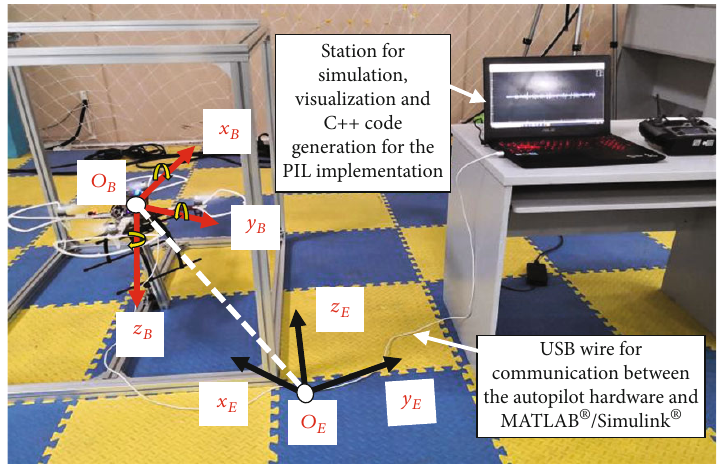
Figure 1: PIL experiment setup: quadrotor model with x -con fi guration represented in E-frame and